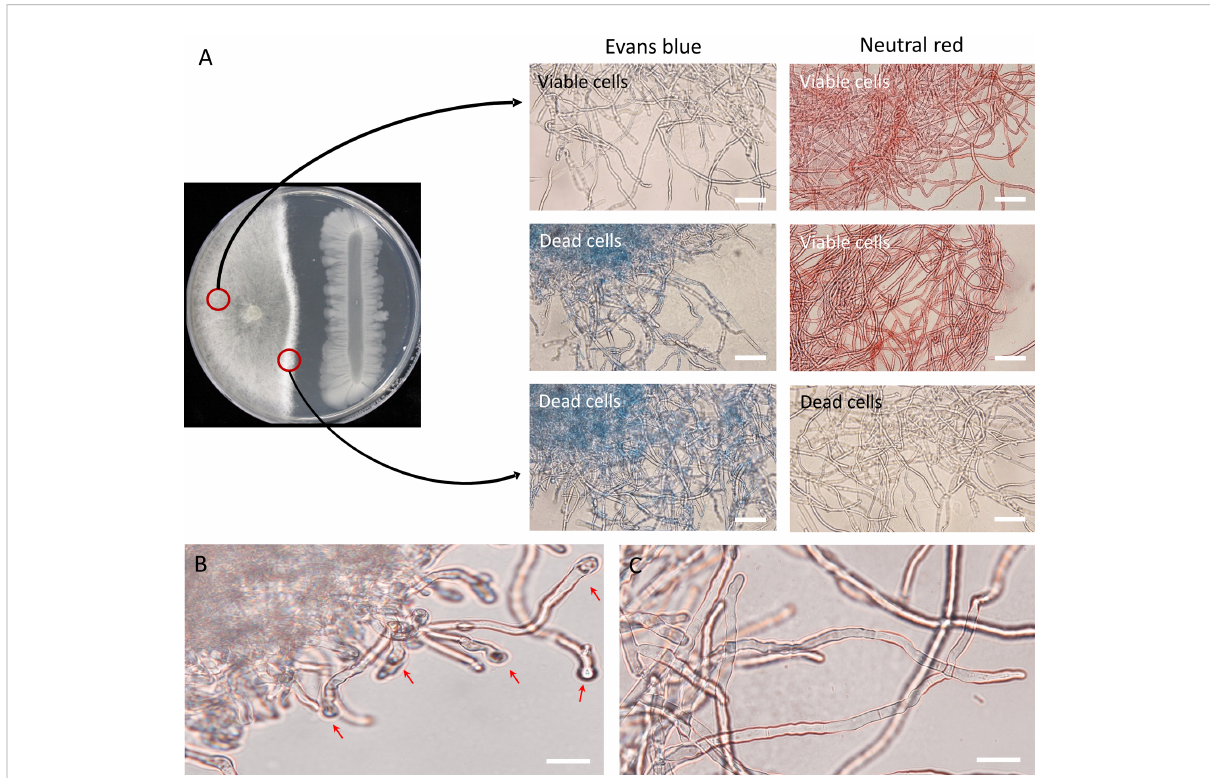
FIGURE 2 Morphological observation of inhibition effect of Bacillus velezensis GH1-13 against R. solani AG2-2 (IIIB). (A) Mycelia of R. solani were stained with Evans blue and neutral red after co-cultivation for 8 days; mycelia growing near GH1-13 stained blue, while those in the control zone exhibited only normal color; in contrast, mycelia that were co-cultured with GH1-13 did not stain red. (B) Roundish cells were observed at terminal hyphae of R. solani during dual culture. (C) Mycelia in the control region showed no inhibition. Scale bars = 50 m